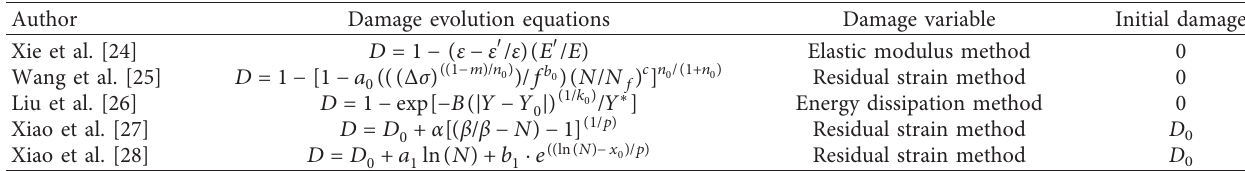
Figure 1: Geothermal values of tunnels in some countries around the world [1]. Table 1: Comparison of damage models.